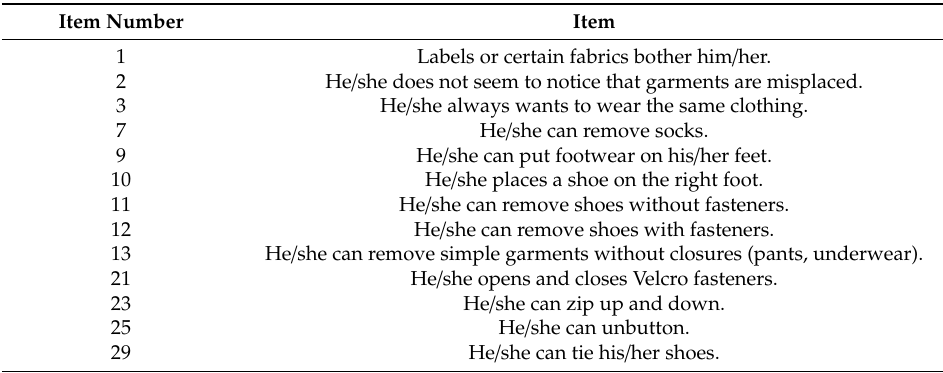
Table 10. Deleted items from the Getting Dressed scale.